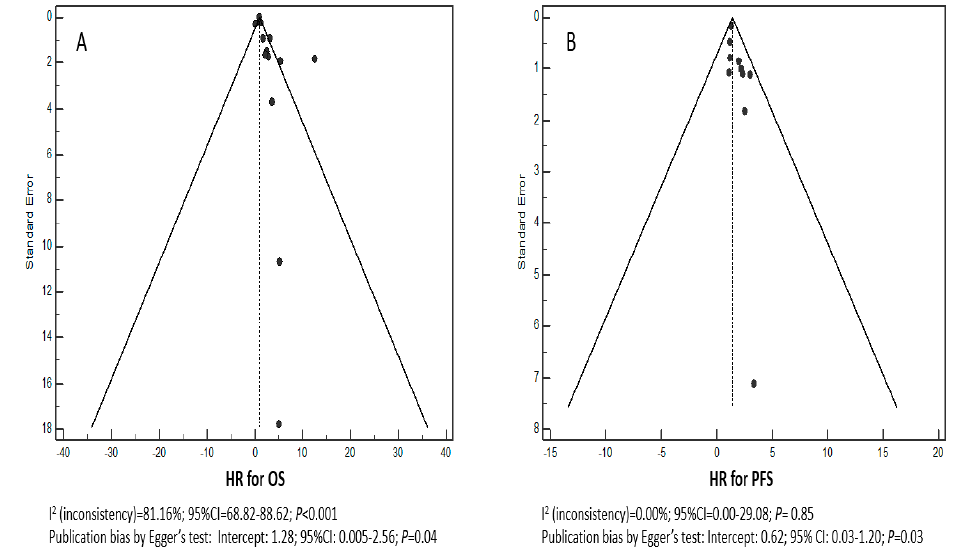
Figure 2. Funnel plots of selected studies for overall survival (OS) ( A ) and progression-free survival (PFS) ( B ).